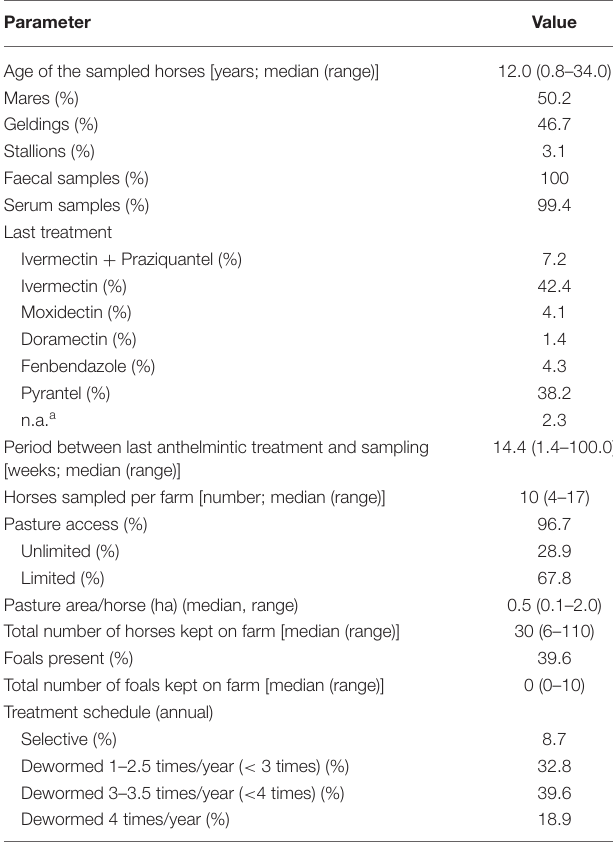
TABLE 2 | General data on the study population (484 horses from 48